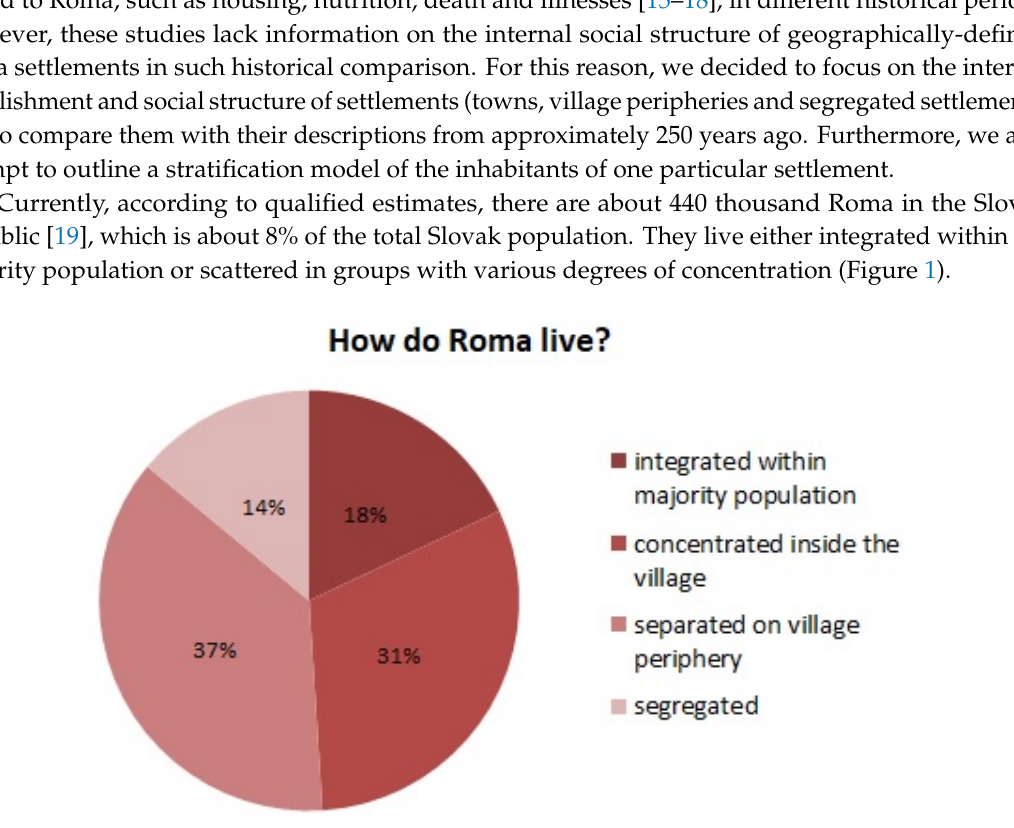
Figure 1. How do Roma live? (Slovakia). Source: Kerekes, 2019 [20].